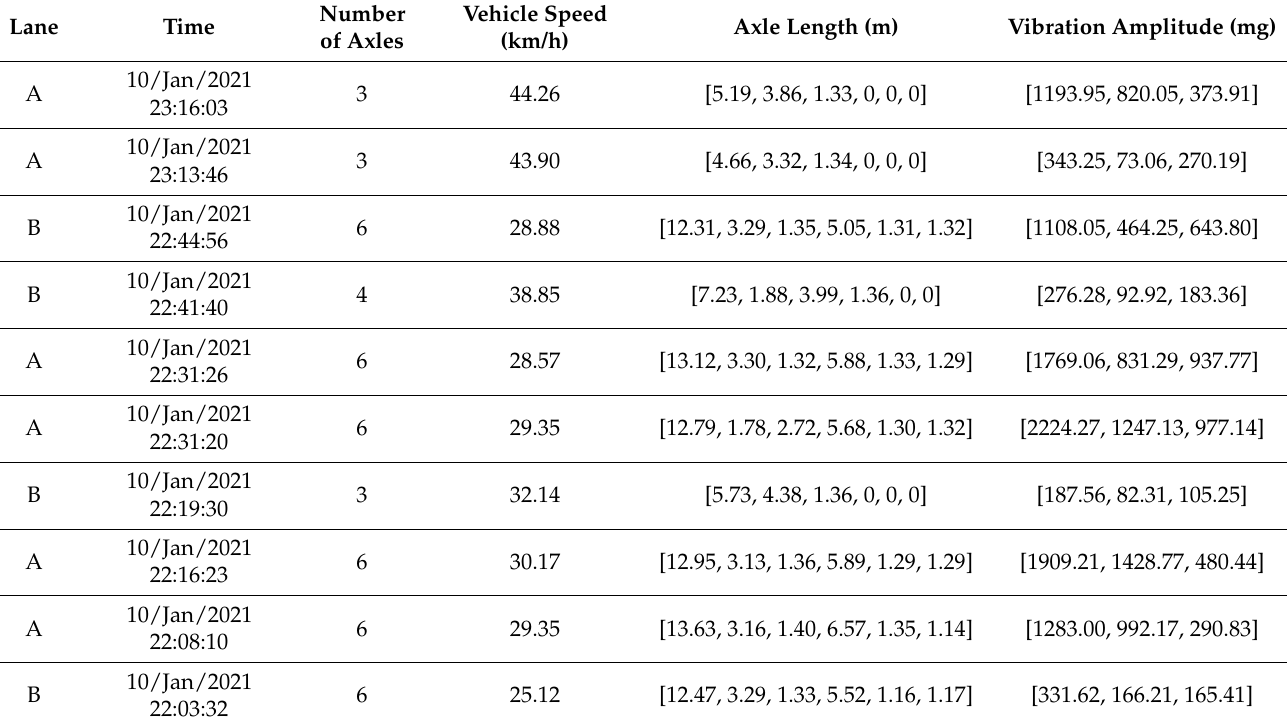
Table 3. Detailed information of vehicles with over three axles.